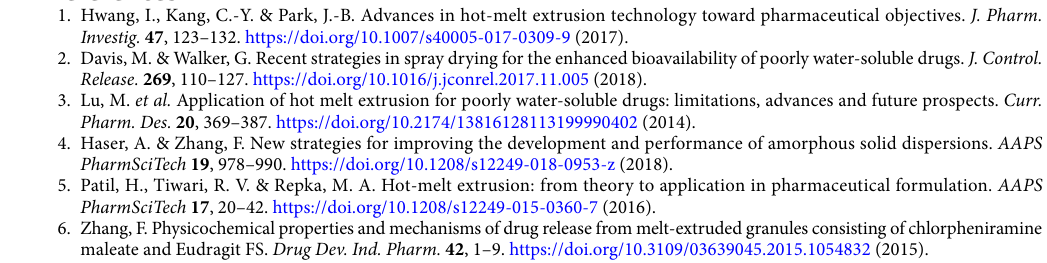
Table 5. Evaluation of Taste masking methods. pH-dep Coacervation method is the developed method in this research so it is provided in bold. *Methacrylic acid divinyl benzene.